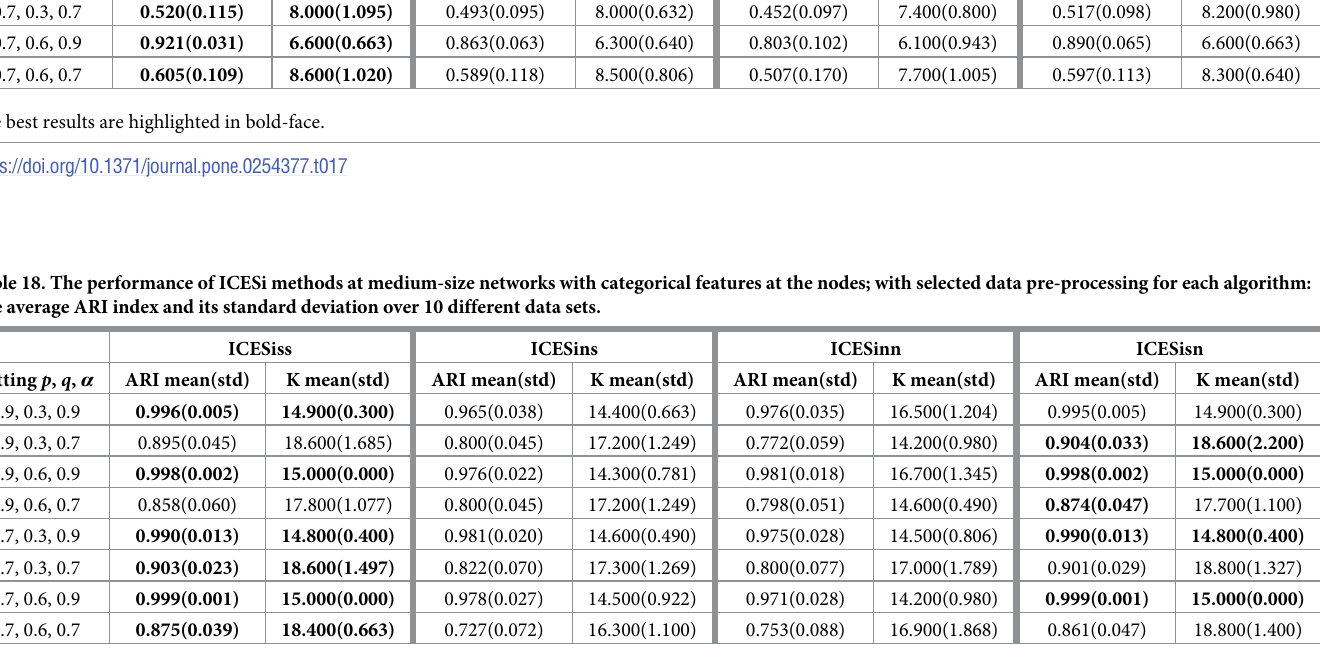
Table 17. The performance of ICESi methods at small-size networks with categorical features at the nodes; with selected data pre-processing for each algorithm: The average ARI index and its standard deviation over 10 different data sets. ICESiss ICESins ICESinn ICESisn Setting p , q , α ARI mean(std) 0.9, 0.3, 0.9 0.9, 0.6, 0.9 0.9, 0.6, 0.7 0.7, 0.3, 0.7